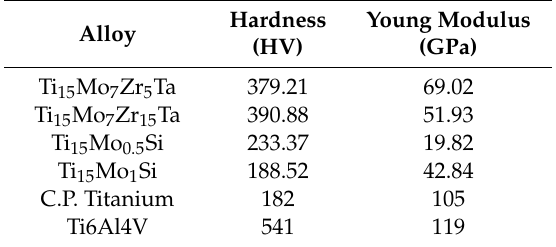
Table 2. Some mechanical properties of titanium